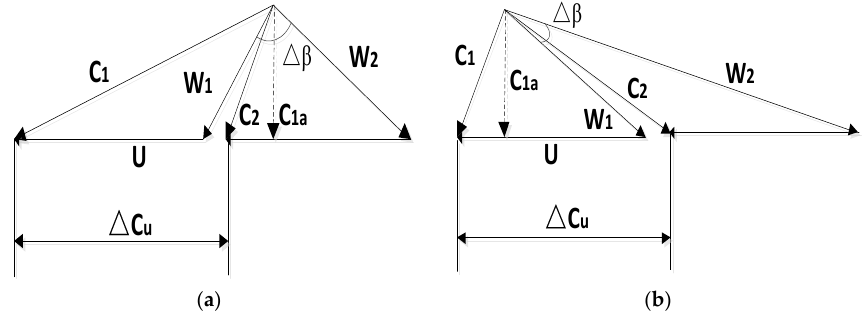
Figure 8. Velocity triangles of the tip turbines: ( a ) conventional method; ( b ) high-reaction-degree Figure 8. method.